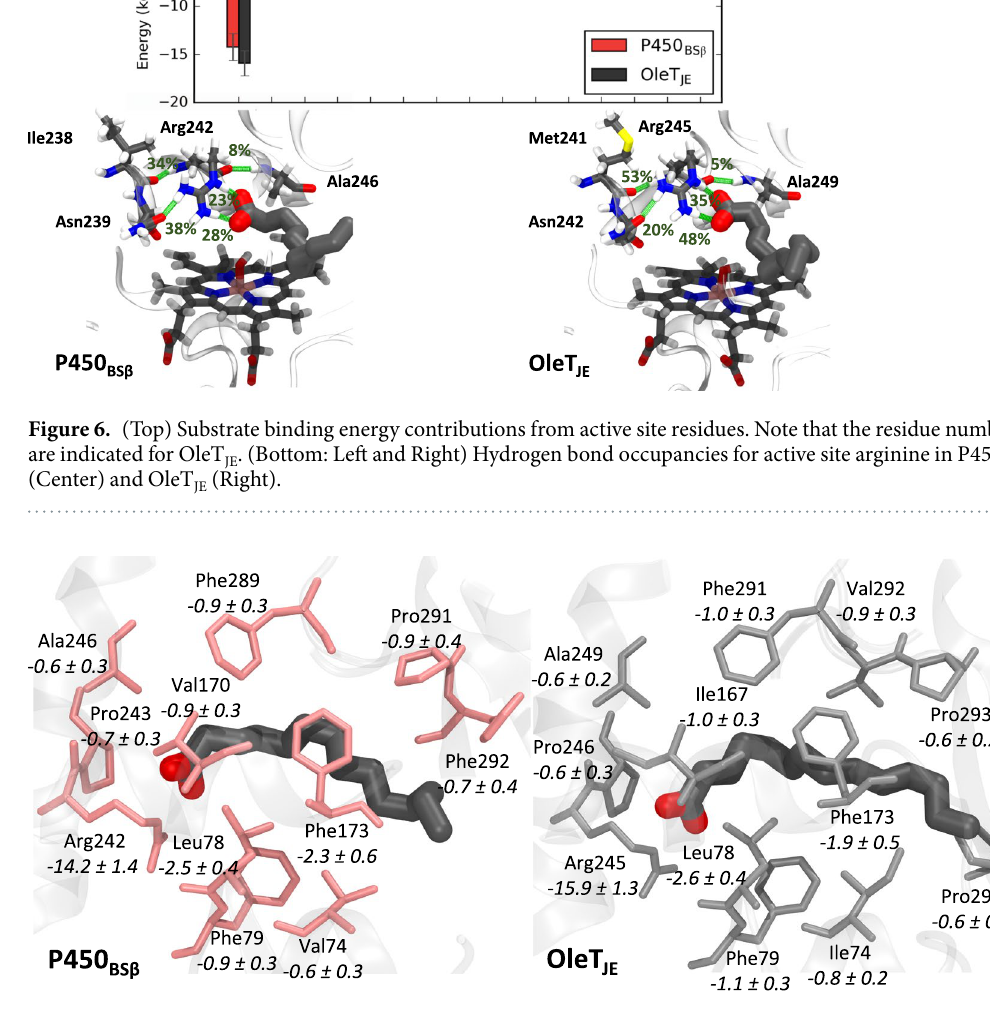
Figure 7. Residue-wise binding energy decomposition for P450 BS β (Left) and OleT JE (Right). The values indicate binding energy contributions and standard deviations calculated over the 150 ns trajectory in kcal/mol. Only residues contributing > 0.5 kcal/mol are considered. All contributing residues are in conserved positions except for Phe287 in P450 BS β and Pro293 in OleT JE